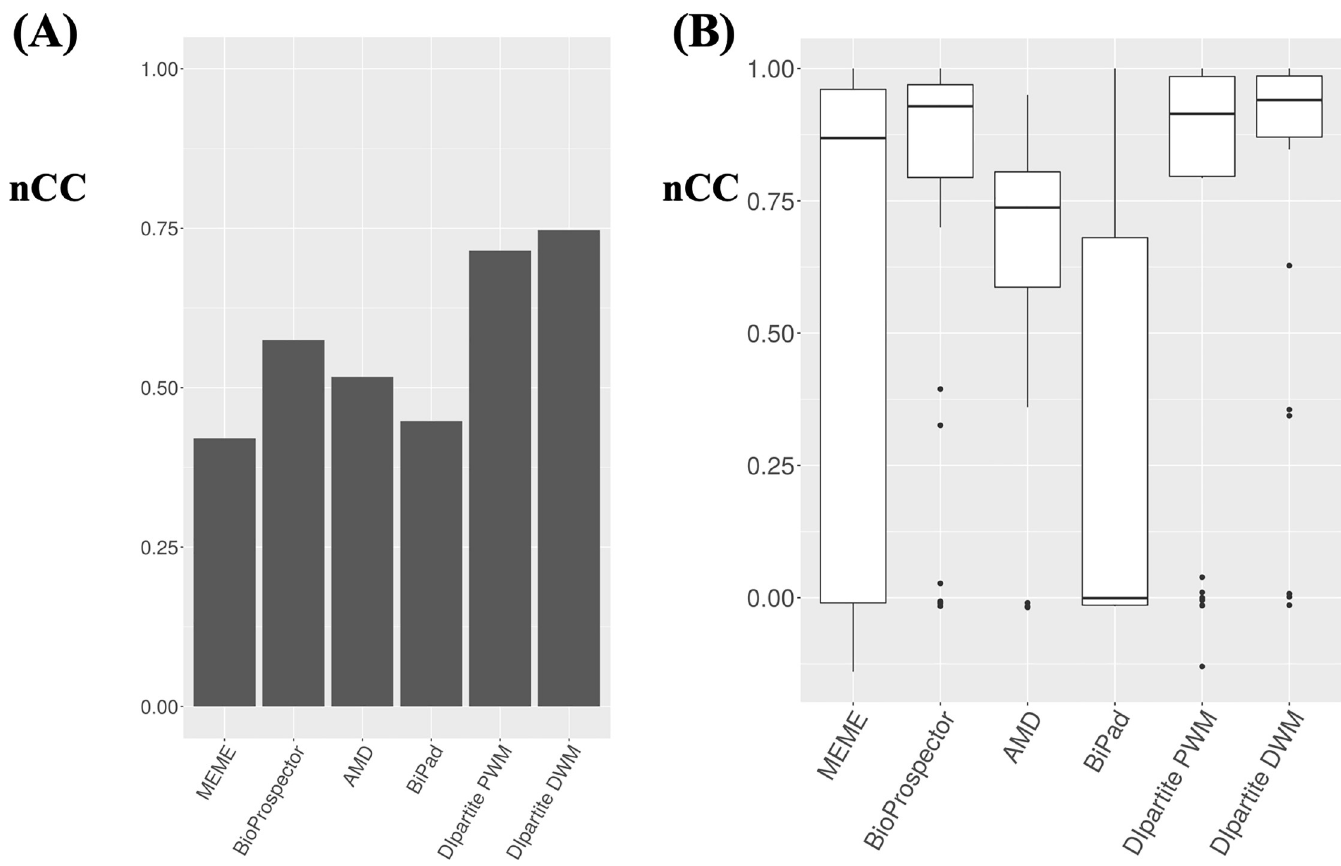
Fig 3. The performance comparison for human promoter datasets. (A) Summary of the results of all 40 human promoter datasets. The combined nCC values were calculated by using a total of 3,054 sequences. (B) Boxplots of the nCC values for each 40 human promoter datasets. All values are shown in S1 Table.